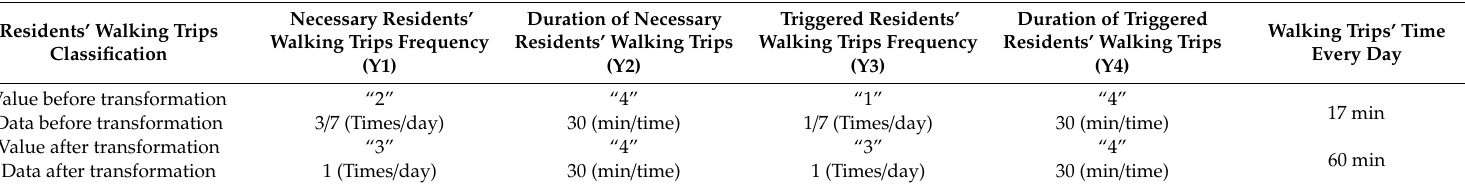
Table 10. Data adjustment of residents’ walking trips 1 .